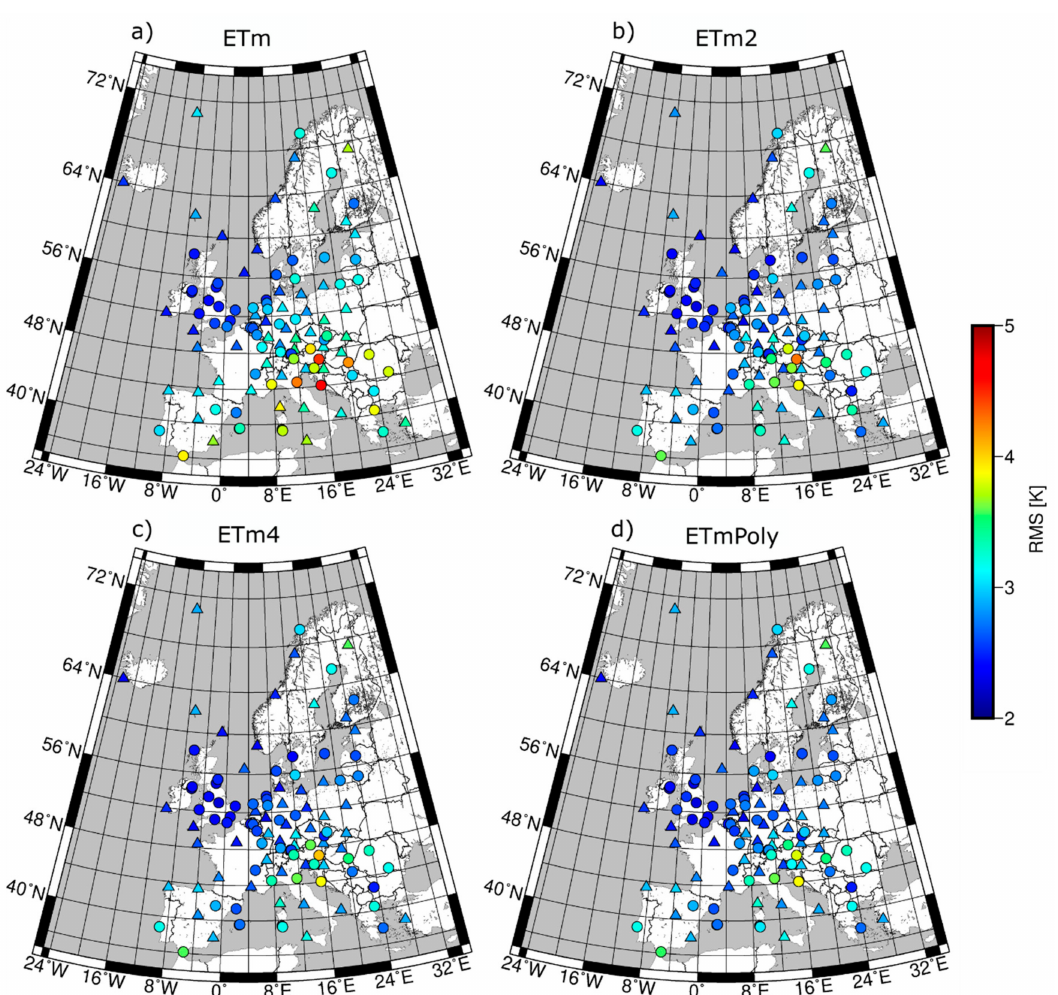
Figure 4. RMS values of T m estimated using ETm ( a ), ETm2 ( b ), ETm4 ( c ), and ETmPoly ( d ) coe ffi cients. RMSE calculated in reference to the in situ measurements performed at RS stations in a period since 1996 to the end of 2018. The circles and the triangles represent RS stations belonging to estimation and external groups,